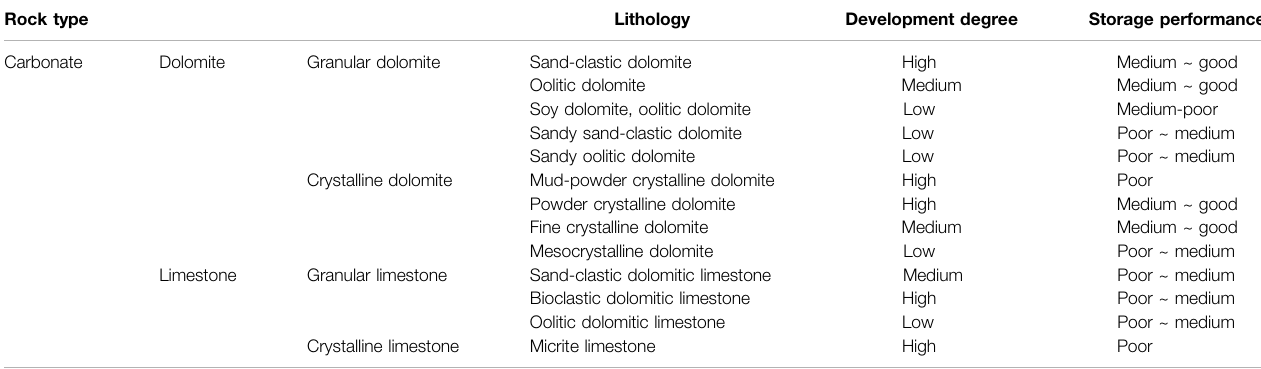
TABLE 1 | Types of reservoir rocks of longwangmiao formation in sichuan